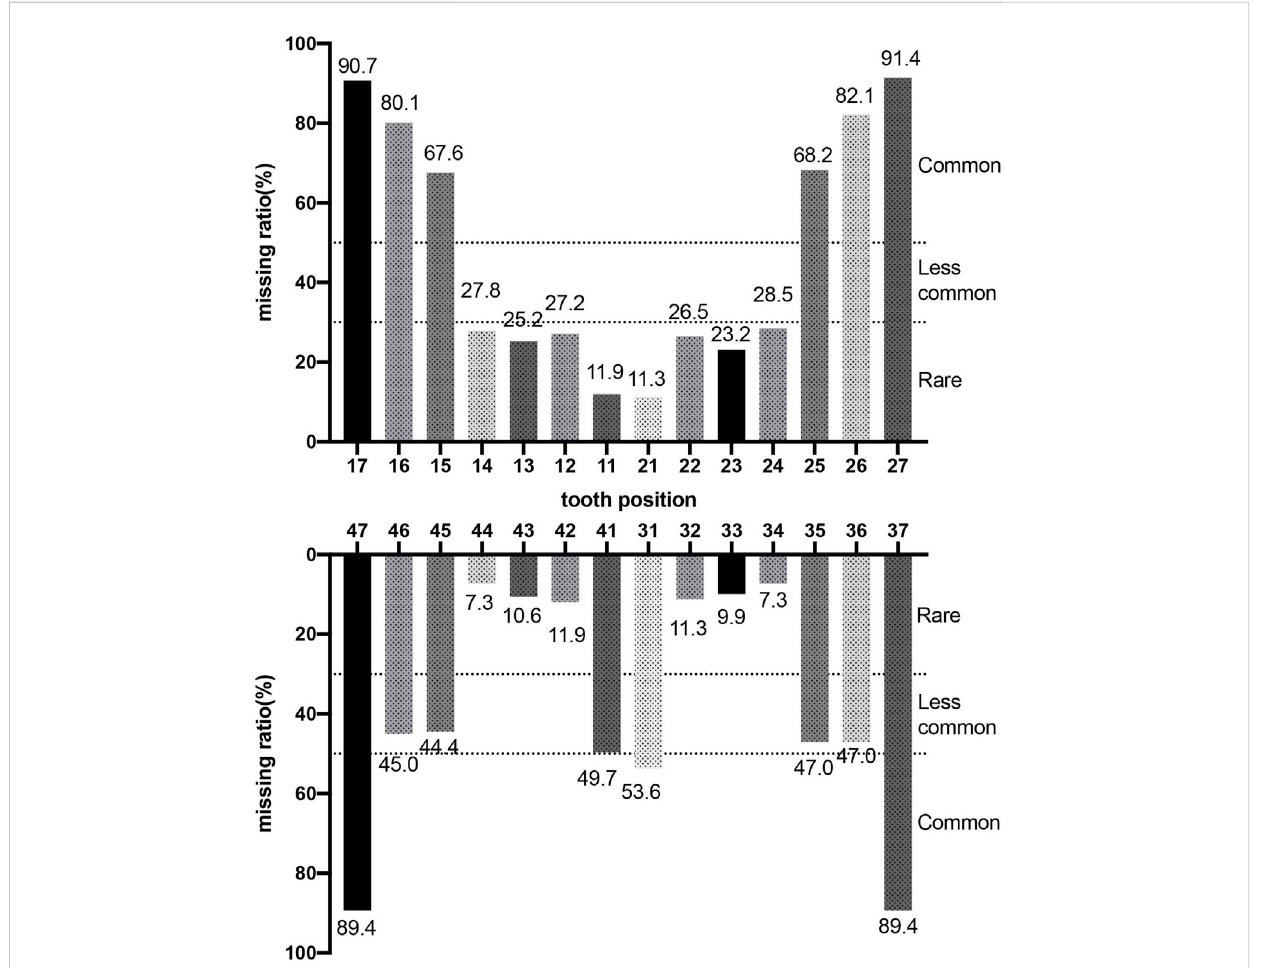
FIGURE 5 Percentage of missing teeth in patients with non-syndromic oligodontia ( n = 151) caused by PAX9 gene